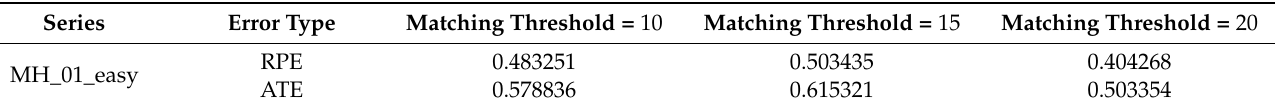
Table 1. Accuracy comparison according to the different matching thresholds for MH_01_easy series. Series Error